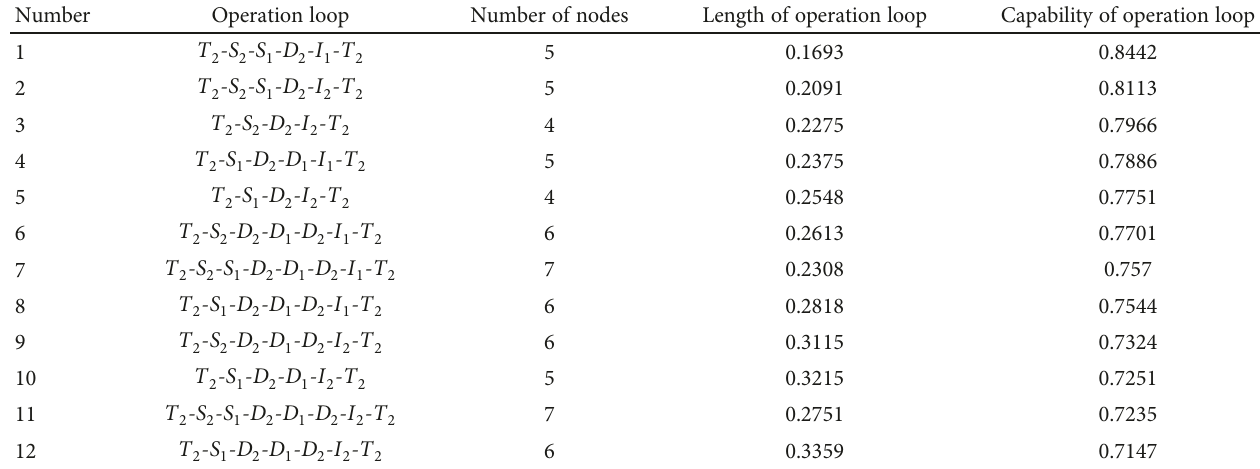
Table 7: Energy and length of operation loops aimed at target T